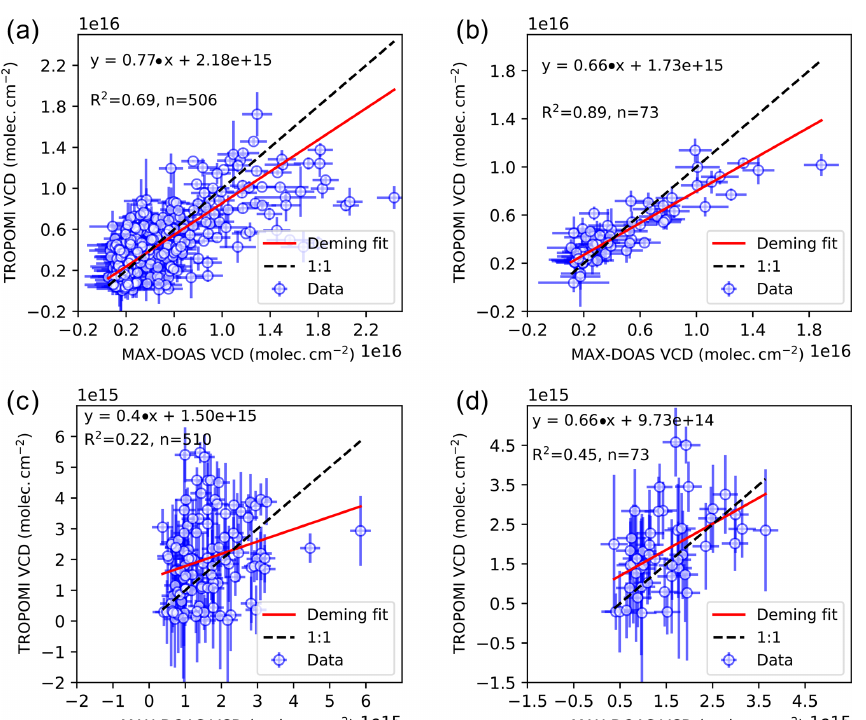
Figure A3. Scatter plot results for the comparison of formaldehyde columns from TROPOMI and the MAX-DOAS (convolved with TROPOMI averaging kernels) between May 2018 and November 2019: (a) Broadmeadows daily measurements, (b) Broadmeadows weekly averages, (c) Lauder daily measurements and (d) Lauder weekly averages.